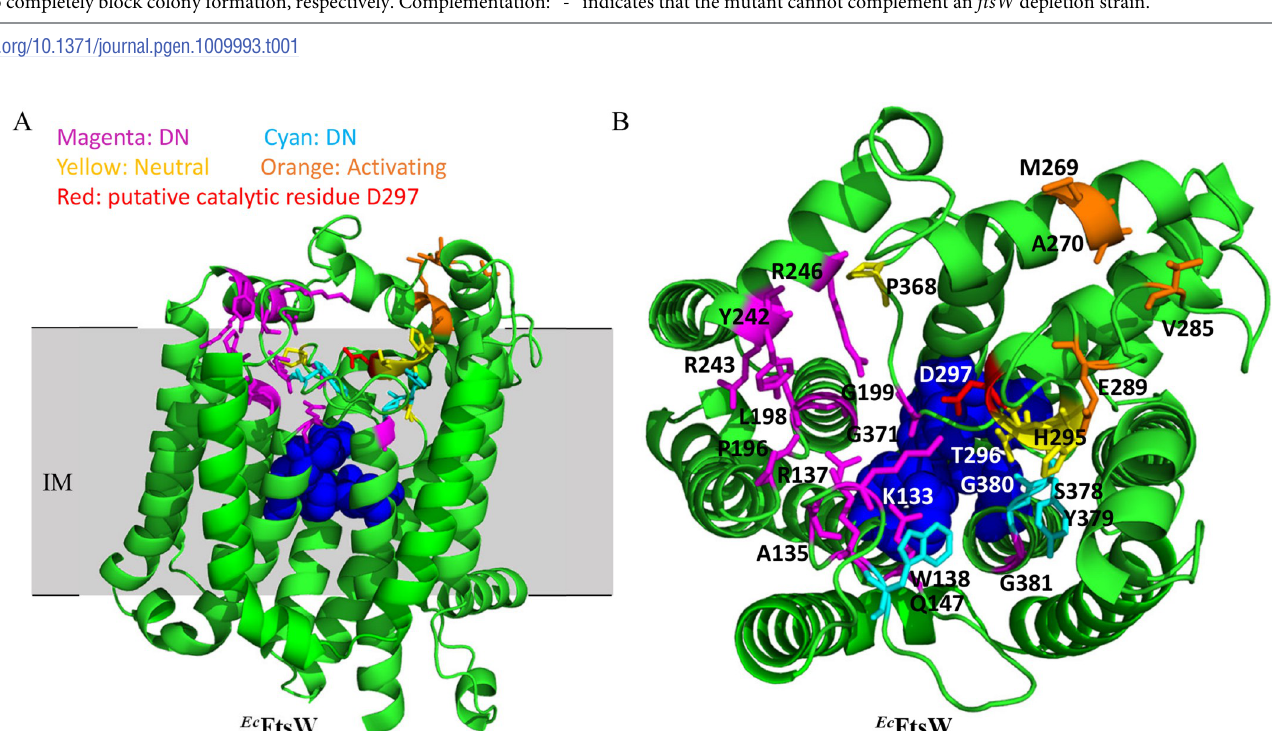
Dominant-negative effect: “++++”, “+++”, “++” and “+” indicate that it takes � 60 μ M, 60–125 μ M, � 125 μ M or � 1000 μ M IPTG to induce the expression of the mutant to completely block colony formation, respectively. Complementation: “-” indicates that the mutant cannot complement an ftsW depletion strain.